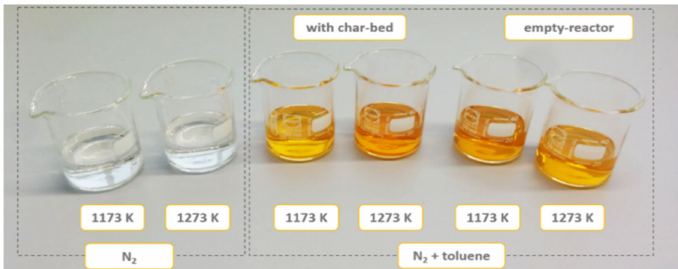
Figure 5. Condensable compounds diluted in isopropanol collected at the reactor outlet after tests with and without toluene at 1173 K and 1273 K (after filtration).